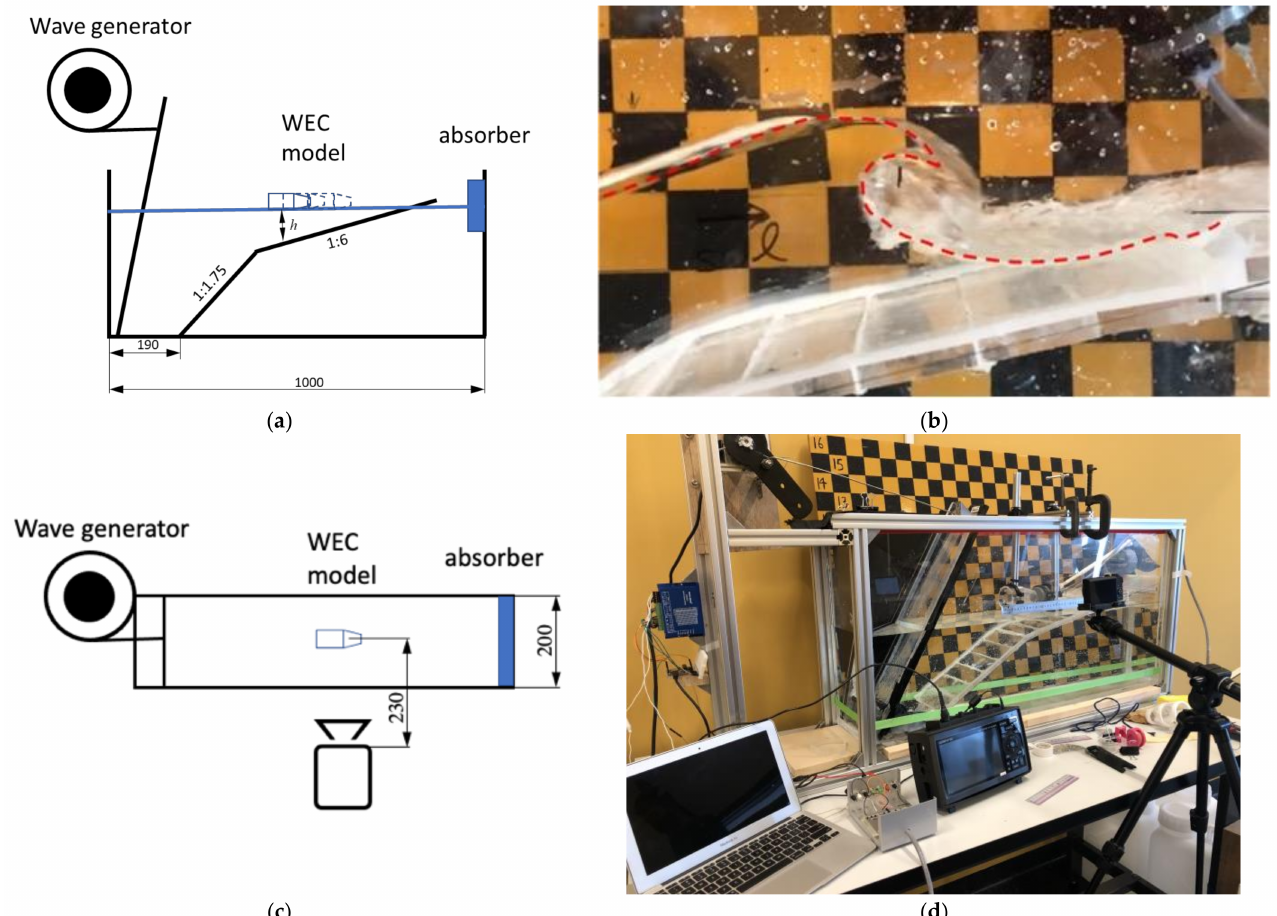
Figure 5. ( a ) Schematics of OIST’s wave flume facility with dimensions in mm. The wave is generated using a wave paddle at one end with a wave absorber installed at the other end. Here, h denotes the water depth at various WEC locations. ( b ) The breaking wave at the breaking wave position with the profile highlighted with a dashed red line. ( c ) Schematics of the high-speed camera location relative to the model location, top view, with ( d ) showing the photograph of the flume and the camera setup for the